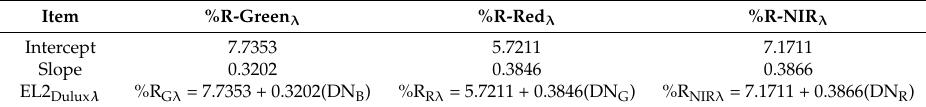
Table 11. EL2 equations from Dulux targets and calibration bracket per camera waveband.